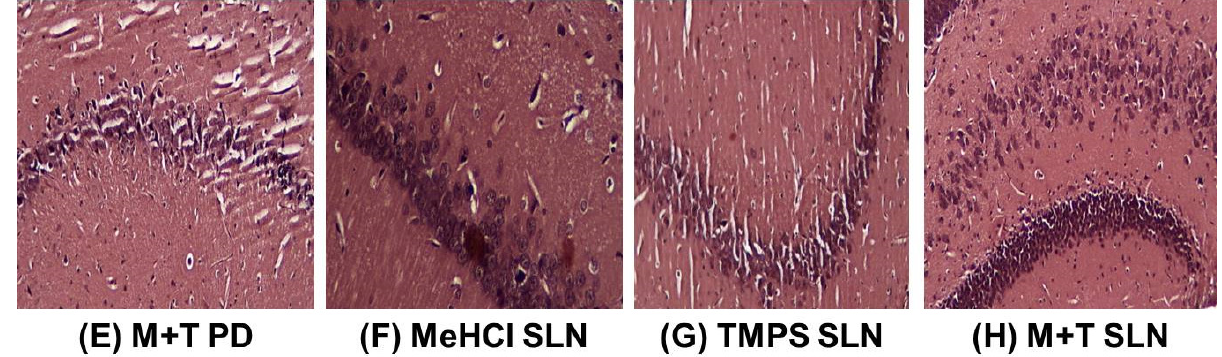
Figure 14. Histopathology of Hippocampal region of rat brain stained with congo red dye ( A ) Control group shows hippocampal neurons appeared normal without any deposition of A β ( B ) AlCl 3 represents the deposition of foci of A β in the CA1, CA2, DG region of hippocampus also adjacent ventricle is filled with A β ( C ) MeHCl PD shows birefringence deposition of multiple foci of A β in CA2 region of the hippocampus ( D ) TMPS PD shows deposition of few foci of A β in CA1 region of the hippocampus ( E ) M + T PD shows deposition of few foci of A β in CA1 region of the hippocampus ( F ) MeHCl SLN showed deposition of few foci of A β in hippocampus neurons of CA1 region ( G ) TMPS SLN showed very few depositions of A β in CA1 region of the hippocampus ( H ) M + T SLN showed deposition of very few foci of A β deposition in various regions of the hip- pocampus.